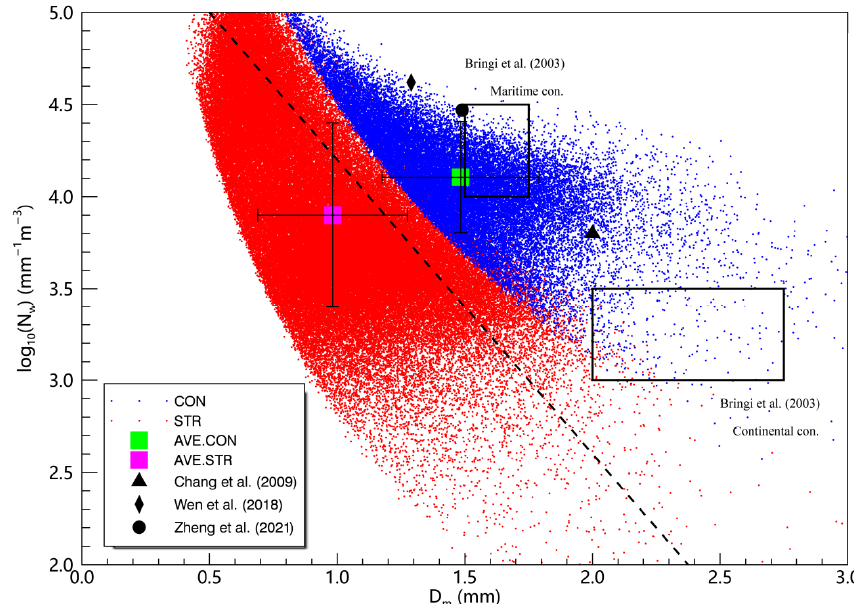
Figure 7. Scatter diagram of log 10 ( N w ) and D m observed from the PARSIVEL disdrometers for convective (blue dots) and stratiform precipitation (red dots) in Typhoon In-Fa. The green and magenta rectangles represent the average values (along with ± standard deviation) of convective rain (denoted as AVE.CON) and stratiform rain (denoted as AVE.STR), respectively. The black triangle, diamond, and circle represent results from other typhoon studies for comparison. The two outlined rectangles correspond to the maritime and continental convective clusters observed by Bringi et al. [23]. The black dashed line indicates the fitting curve of stratiform rain in Bringi et al. [23].